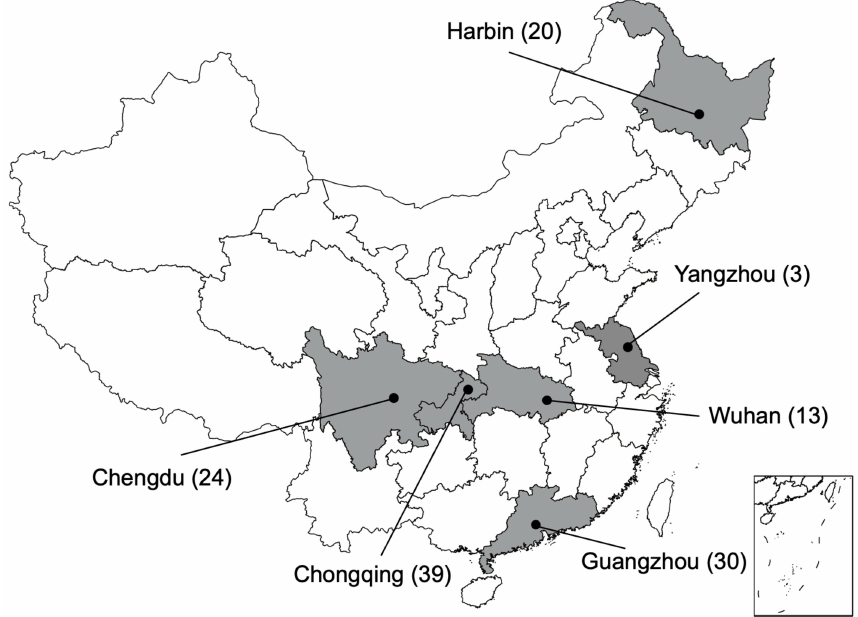
Figure 1. Map of sampling sites. The black dots represent the cities that the veterinary clinics were located in. The number of samples are marked after the name of